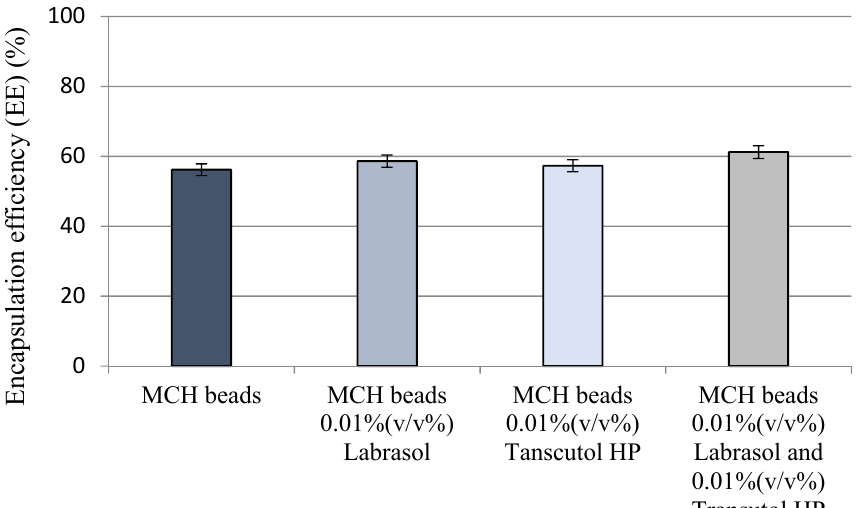
Figure 1. Results of encapsulation efficiency measurements regarding the different formulations containing MCH. Although there is no major difference in encapsulation efficiency between the formulations, beads containing both Labrasol and Transcutol HP as penetration enhancers showed the highest EE value. Each data point represents the mean ± SD, n = 3.